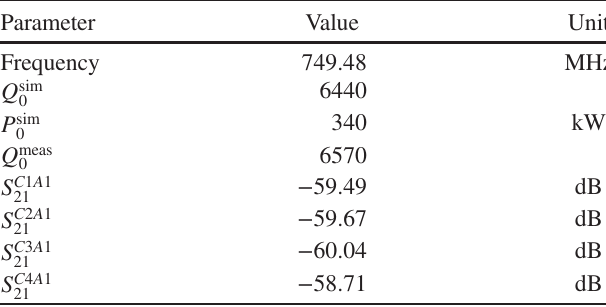
TABLE VII. Parameters used for